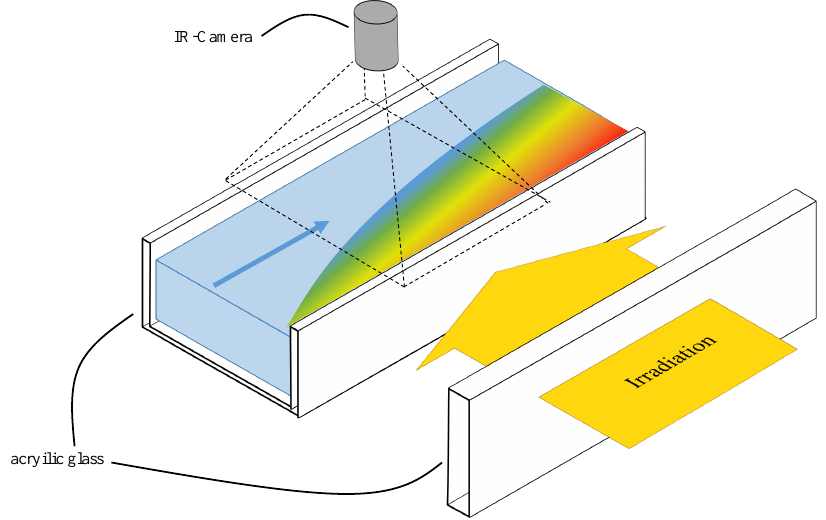
Figure 12. Experimental setup for the validation measurements with IR-camera and open channel.